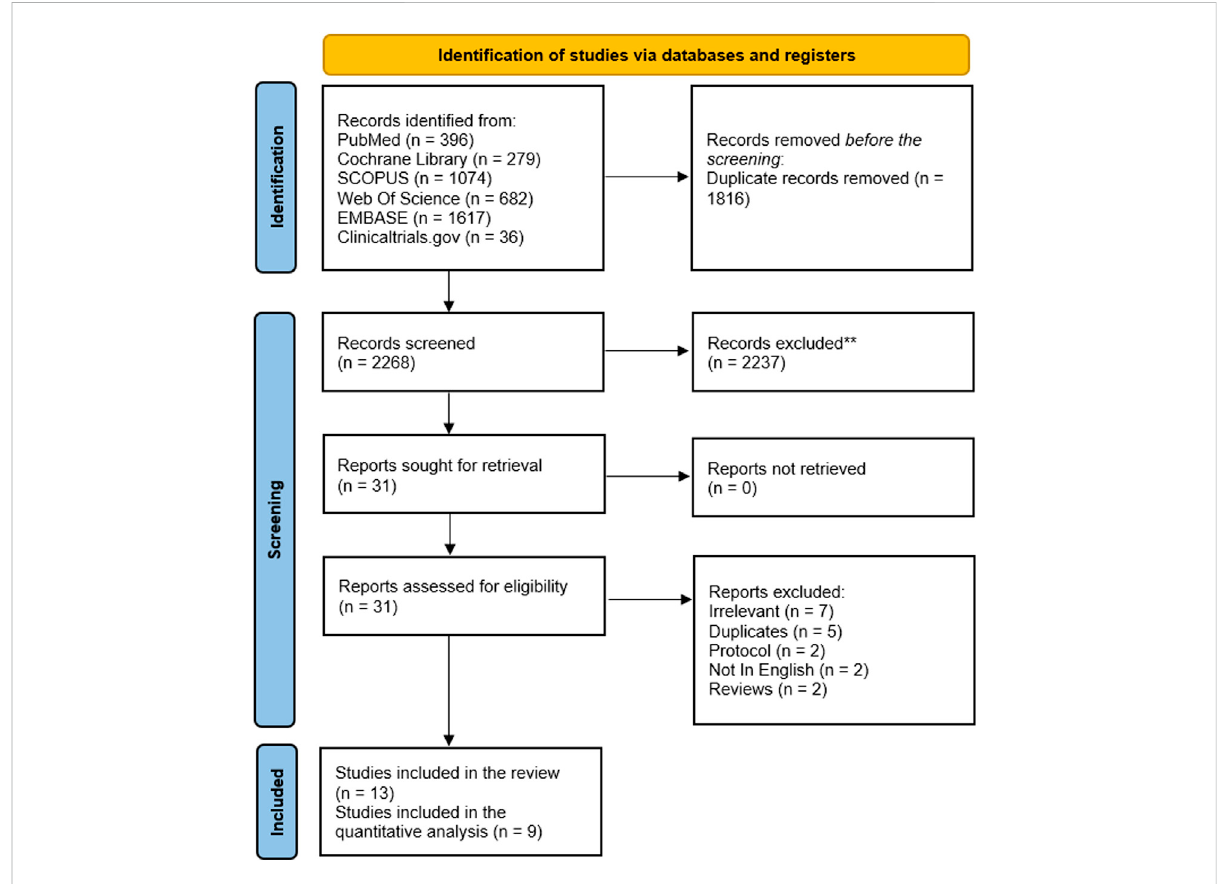
FIGURE 1 PRISMA fl ow diagram of the included